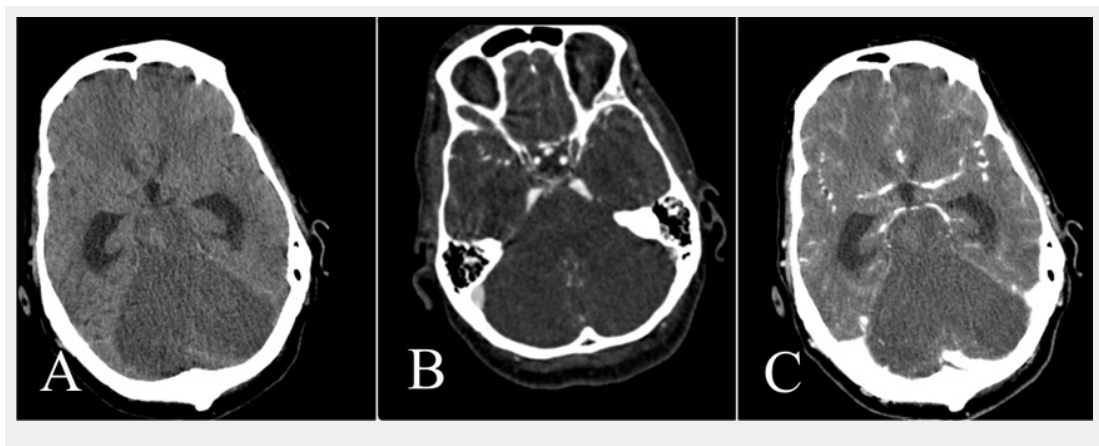
Figure 4 Unenhanced CT (A), CTA (B), and venous-phase CT (C). Note normal opacification of the supratentorial vessels. Brain death could not be confirmed although there is extensive infarction of the cerebellum, pons and brainstem. The supratentorial ventricles are